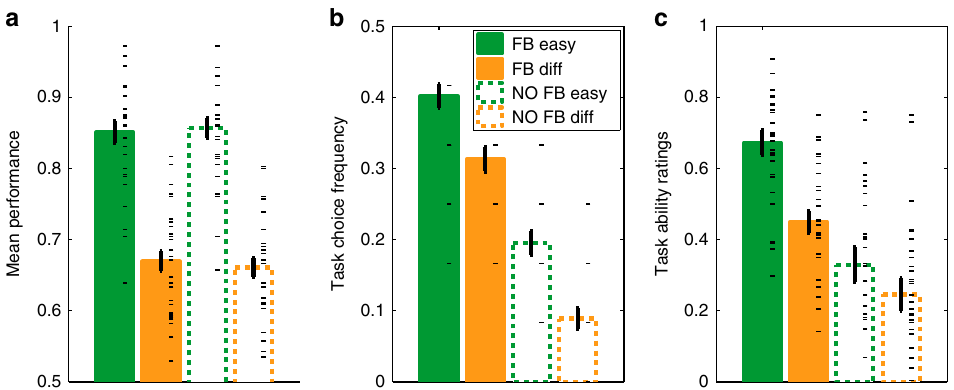
Fig. 2 Behavioral dissociation between objective performance and SPEs in Experiment 1 ( N = 29). a Performance (mean percent correct) was better for easy than dif fi cult tasks, but was not different in tasks with and without feedback. Global self-performance estimates (SPEs) as measured directly by task choice ( b ) or indirectly via task ratings ( c ) were higher in the presence than in the absence of feedback, despite objective performance being unchanged. Error bars represent S.E.M. across subjects. Black dashes are individual data points (there are fewer task choice data points due to the limited number of blocks